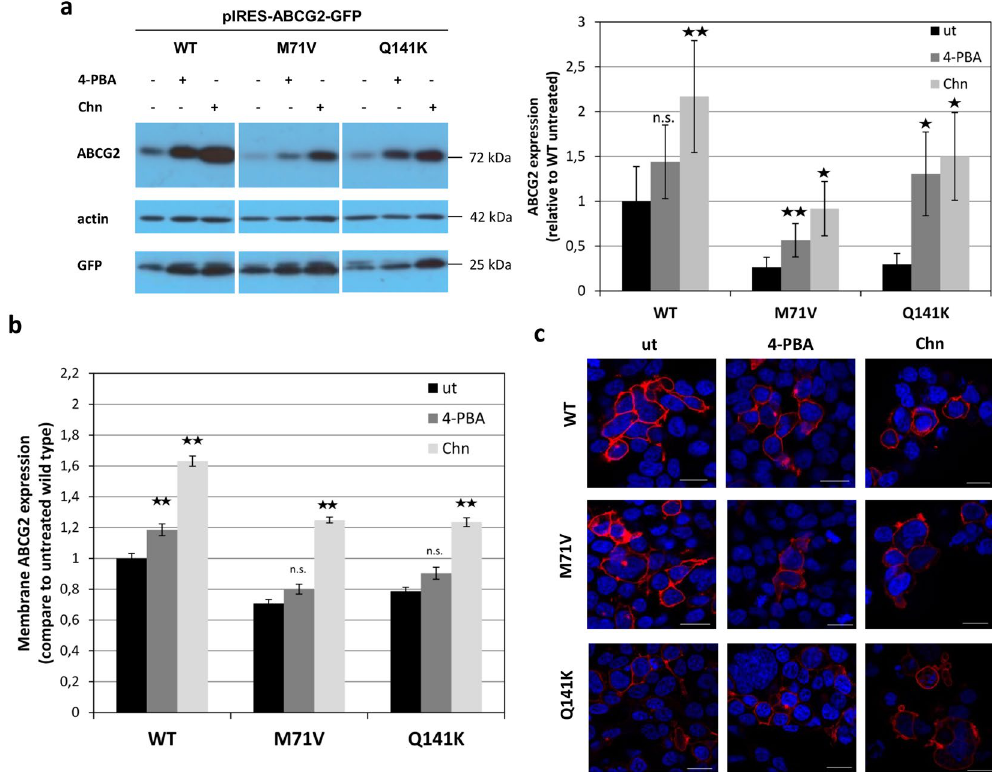
Figure 5. Impact of 4-PBA and colchicine on the expression and membrane localization of the ABCG2 wild type and the ABCG2-M71V protein in HEK293 cells. (Panel a) Total ABCG2 expression determined by immunoblotting in HEK293 cells transfected with the ABCG2-IRES-GFP vector, following a 24-hour exposure to 1 mM 4-phenylbutyrate (4-PBA) or 1 µ M colchicine (Chn). Left side: Western blot. The different proteins examined in the Western blot were developed by the respective antibodies and cropped from the indicated parts of the same gel and blot. Right side: the results are presented as relative expression levels, compared to that of the untreated ABCG2-Wt. Bars represent the mean relative expression ( ± SEM) values from three independent experiments. (Panel b) Surface localized ABCG2 protein expressions in the HEK293 cells, treated as above, were detected by 5D3 antibody binding determined in flow cytometry ( ± SEM, significance assessed by Student’s t-test). (Panel c) ABCG2 expression in the HEK293 cells treated as above, determined by Bxp-21 antibody labeling (red) following a 24-hour 4-PBA or colchicine treatment. Nuclei are stained blue by DAPI. Scale bars represent 20 µ m. (ut: untreated, Chn: